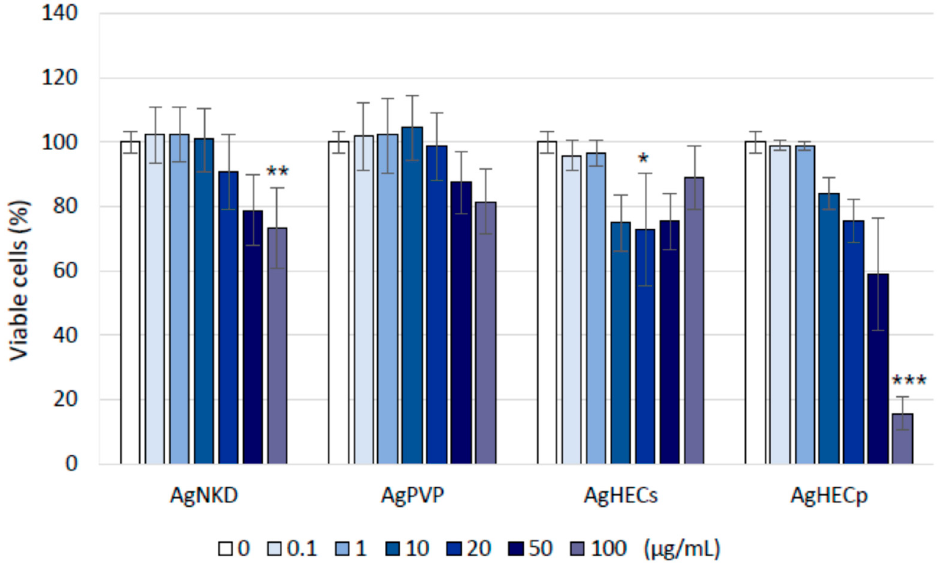
Figure 4. Cell viability. The graphs show the percentages of cell viability compared to the negative control, assessed by Alamar Blue assay after 24 h of treatment. Data are presented as the mean of at least three independent experiments ± SE. Statistical analysis: one-way ANOVA followed by Dunnett’s test. * p < 0.05 compared to control; ** p < 0.01 compared to control; *** p < 0.001 compared to control group.